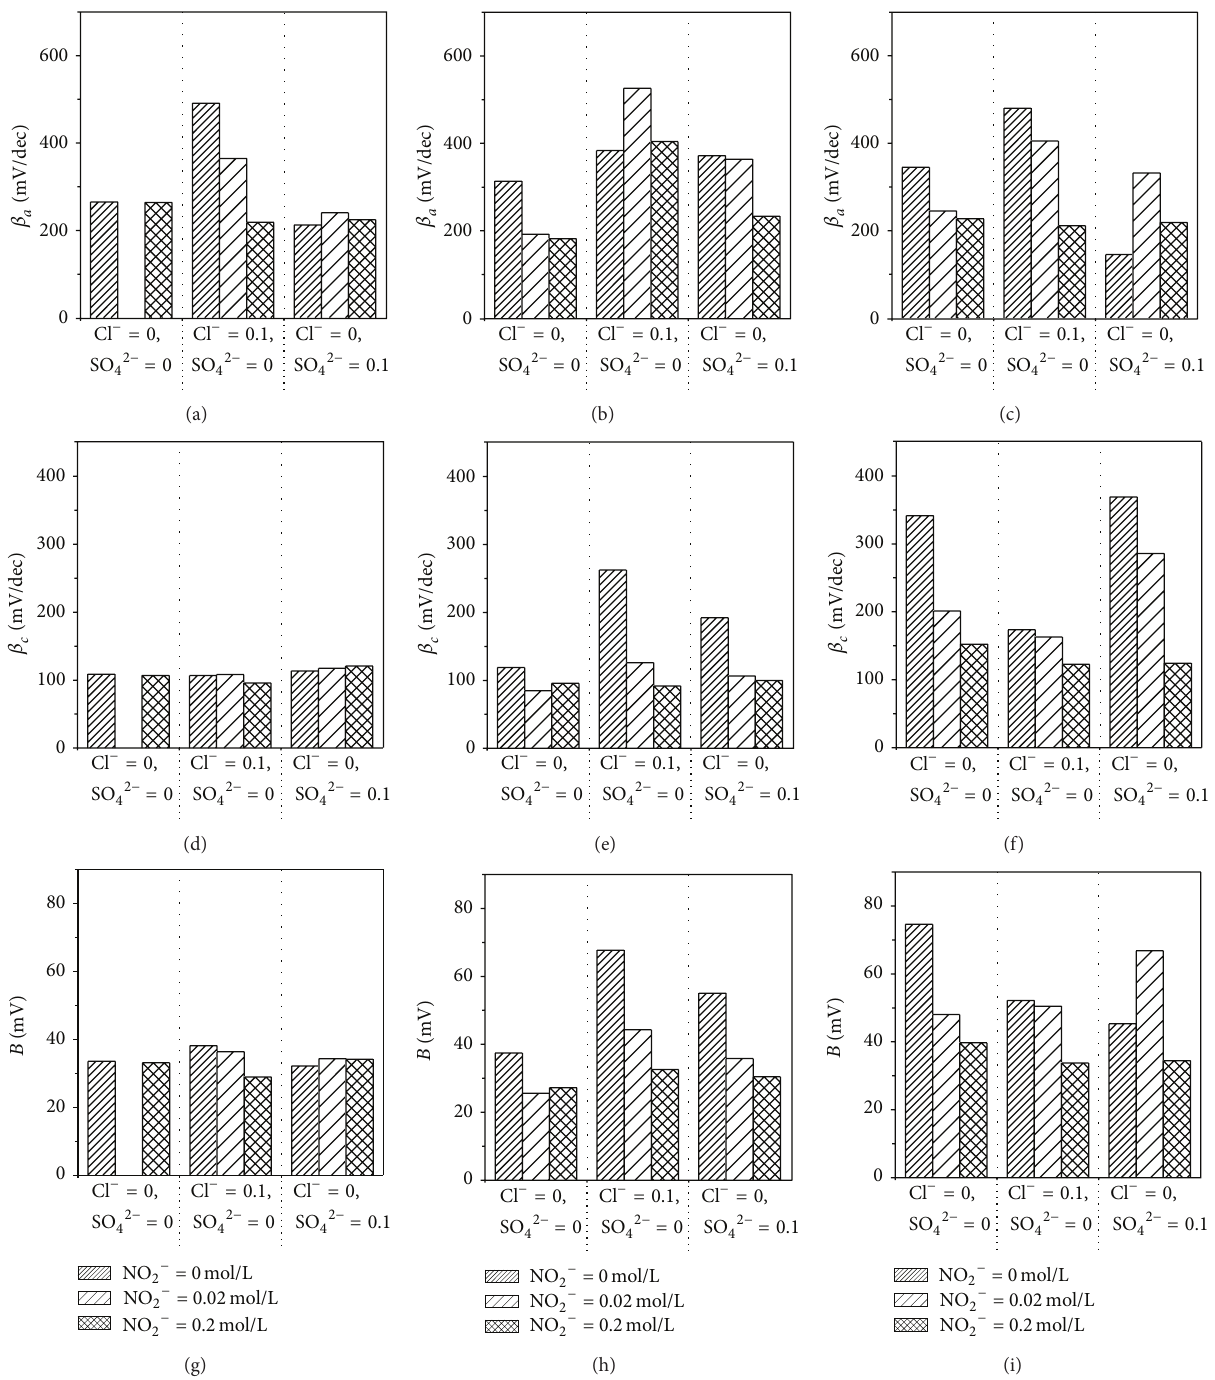
Figure 16: Effect of NO 2− concentration on Tafel slope and Stern-Geary constant 𝐵 . (a) 𝛽 𝑎 in pH 12.6, (b) 𝛽 𝑎 in pH 10.3, (c) 𝛽 𝑎 in pH 8.1, (d) 𝛽 𝑐 in pH 12.6, (e) 𝛽 𝑐 in pH 10.3, (f) 𝛽 𝑐 in pH 8.1, (g) 𝐵 in pH 12.6, (h) 𝐵 in pH 10.3, and (i) 𝐵 in pH 8.1.